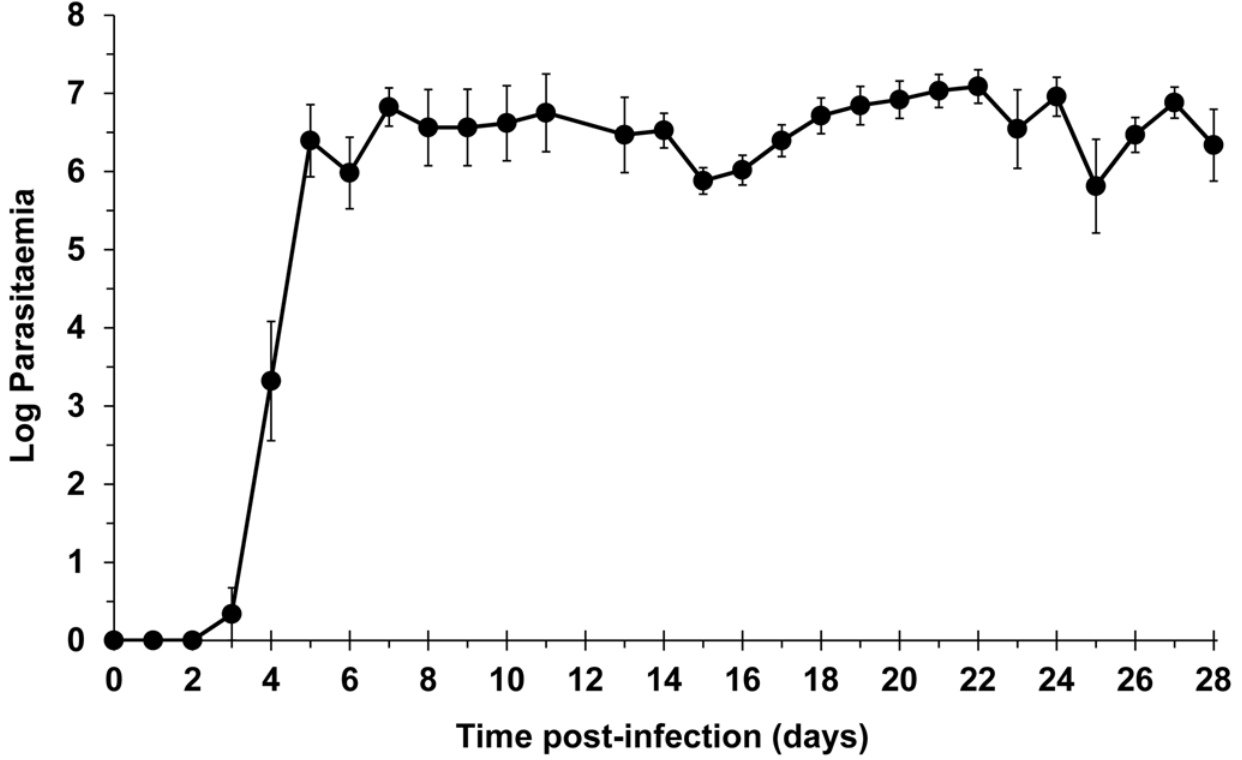
Fig 2. Parasitaemia progression in vervet monkeys following infection. Monkeys were infected with T. b. rhodesiense KETRI 2537 on Day 0. Symbols represent means and standard error of the mean (n = 16).